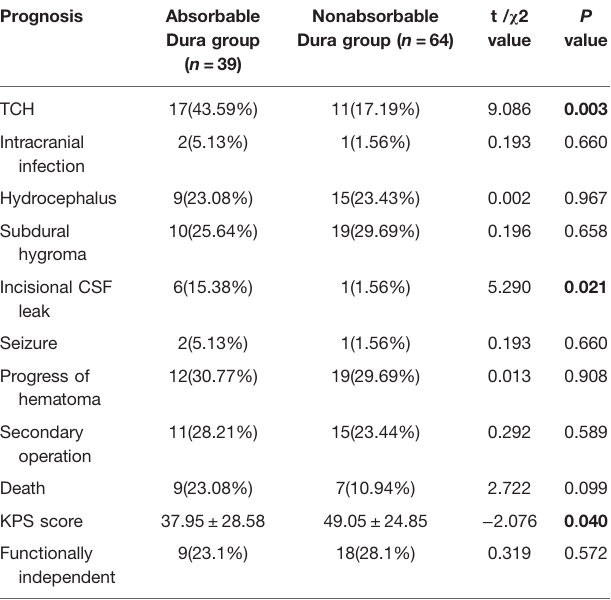
TABLE 2 | Surgical outcomes of absorbable dura group and nonabsorbable dura group. Prognosis